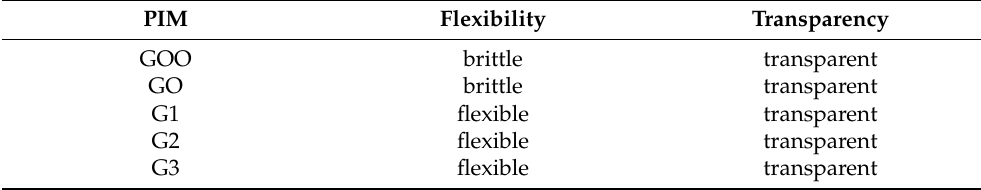
Table 2. Physical properties of the pristine, control, and graphene oxide-doped